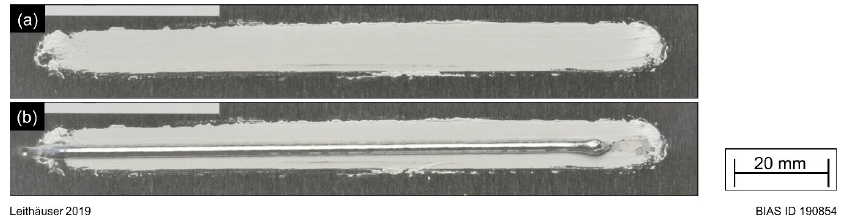
Figure 1. Picture of a sample with flux applied ( a ) before and ( b ) after the laser brazing.